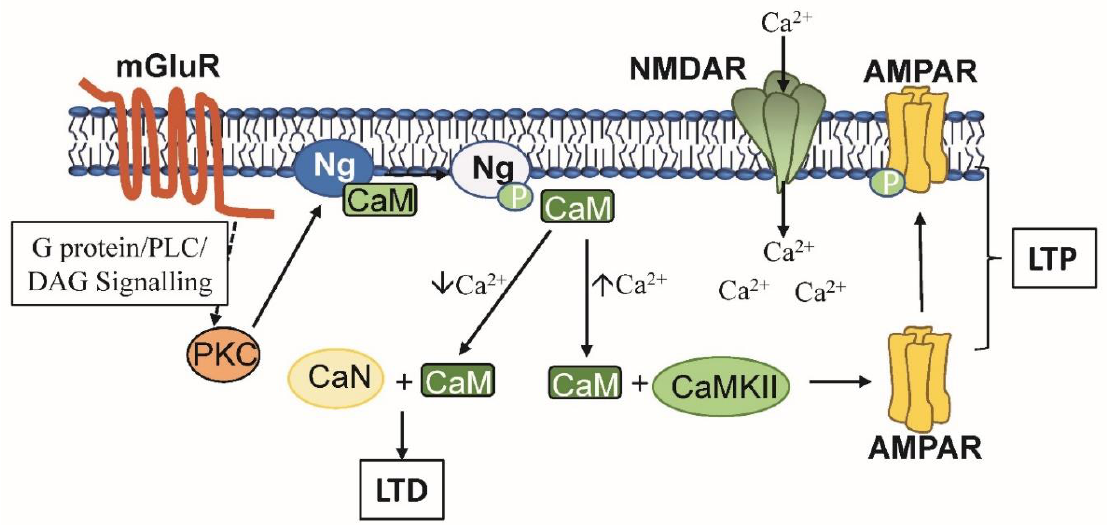
Figure 2. A model for LTP involving regulation mediated by calmodulin (CaM) and neurogranin (Ng). Activation of NMDARs causes a calcium influx activating Ca 2 + / CaM that activates CaMKII. CaMKII phosphorylates AMPARs leading to their translocation and insertion into the post-synaptic membrane. Activation of mGluR initiates G protein / PLC / DAG mediated signaling to activate PKC. PKC phosphorylates Ng preventing CaM binding and allowing CaM to continue activating CaMKII. See text for details.